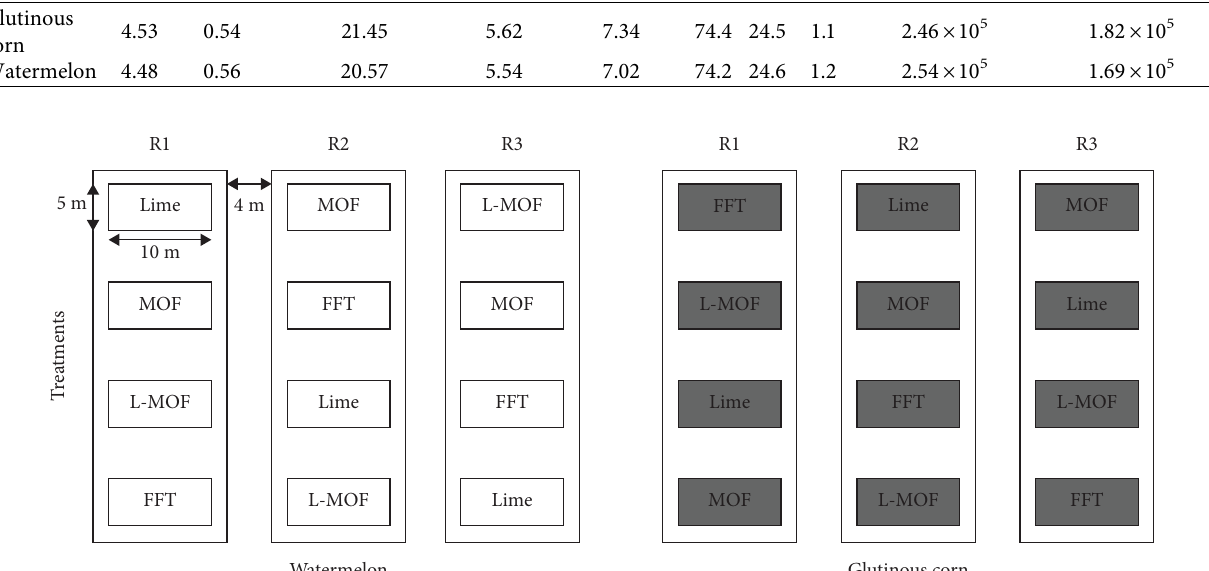
Figure 1: Experimental feld layout. R: replication; MOF: microbial organic fertilizer; L-MOF: lime and microbial organic fertilizer treatment; FFT: fertilizer following farmer dose treatment. Table 2: Amount (kg/ha) and percentage (%) of applied fertilizer at diferent treatments for glutinous corn and watermelon. Crops